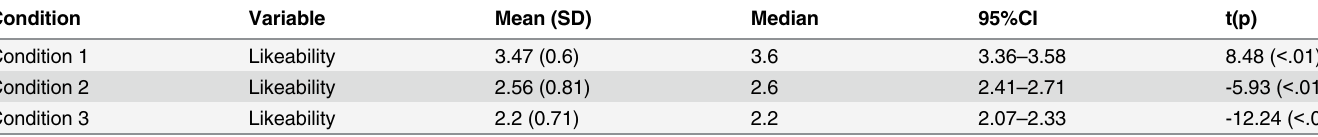
Table 3. Descriptive statistics